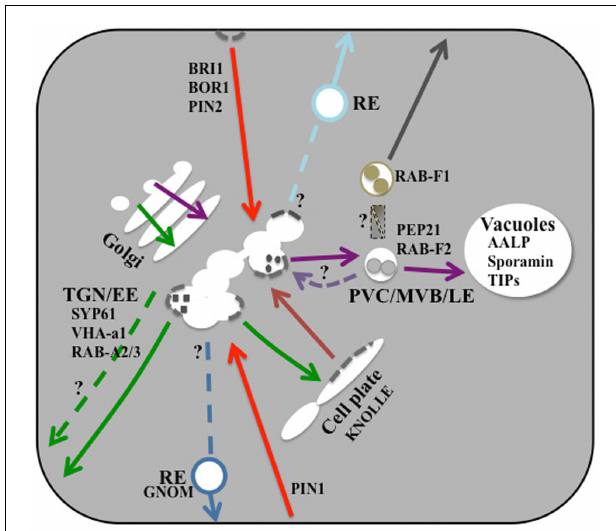
FIGURE 1 | Illustrated overview of post-Golgi traffic. In the vacuolar trafficking pathway (purple-colored), there is a controversy over the precise location whereVSR recycling occurs (pale purple-colored dashed line). There are different populations of RAB-F-positive endosomes, but their origin is unknown.There is no clear evidence for multiple secretory pathways to the PM (indicated by the green-colored dashed line). Cell-plate formation mainly relies on the secretory pathway (green-colored). Molecular machineries involved in protein retrieval from the cell plate (salmon-colored) and in endocytosis (red-colored) may be similar, including clathrin (gray-colored dashed line). It is not clear whether clathrin is also involved in the vacuolar trafficking pathway. Although there seem to be multiple types of REs (blue and pale blue-colored), their origin and identity are unknown. Small-sized letters indicate representative molecular markers for post-Golgi trafficking pathways. For simplicity, polar location of BOR1 is not shown. For details, see the